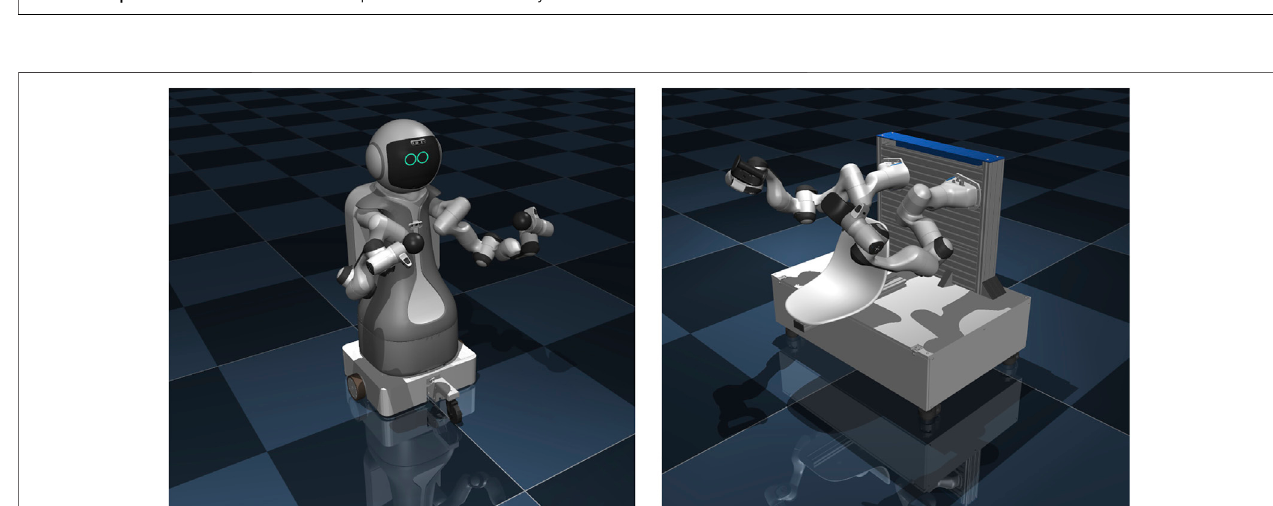
FIGURE3| VisualizationofourtwoprimarydigitaltwinmodelsinMuJoCo.ThemodelofthehumanoidrobotGARMIshownontheleftincludesfullyactuatedarms, head and a friction driven differential drive system with castor wheels and passive suspension. The model of PARTI to the right also features a fully actuated two-arm system. These models can run purely in a software environment or be coupled to the real hardware using the haptic or HIL interfaces.